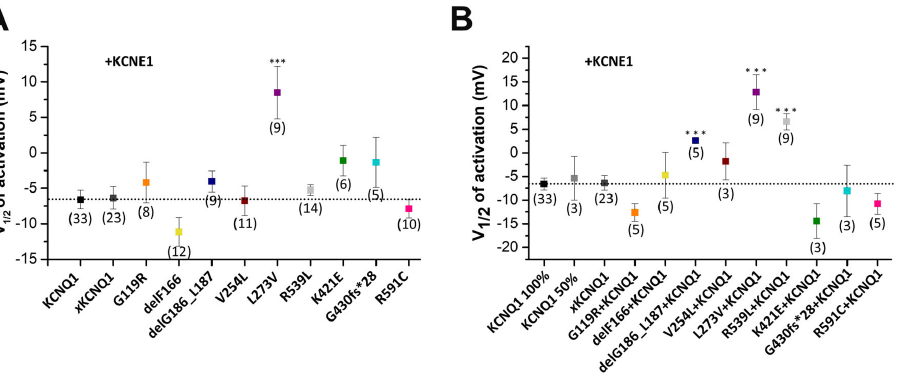
Figure 7. Voltage-dependence of activation of the KCNQ1 variants expressed in a homozygous or heterozygous complex with KCNE1. ( A ) Voltage-dependence of activation for homozygous KCNQ1 variants co-expressed with KCNE1 (81.2 ng KCNQ1 variants plus 1 ng KCNE1 or ( B ) in a heterozygous state with wild-type KCNQ1 and KCNE1 (40.6 ng KCNQ1 + 40.6 ng KCNQ1 variants + 1 ng KCNE1. Controls were: KCNQ1 100% = 81.2 ng KCNQ1 + 1 ng KCNE1, KCNQ1 50% = 40.6 ng KCNQ1 + 1 ng KCNE1, x KCNQ1 = 1 ng KCNE1. The tail current of each variant after the 7 s pulse was normalized to their maximum current. Recordings were performed with the protocol as described in Figure 6. The tail currents recorded after the 7 s pulse were normalized to the respective maximal tail current of each recording, to obtain the conductance/voltage (G/V) curves. Normalized tail currents were fitted to the Boltzmann function. The voltage of half-maximal activation (V 1/2 ) of the respective construct is illustrated, together with the numbers of oocytes analyzed. Values are expressed as means ± S.E.M. Error bars represent S.E.M. values. Significance was assessed using two tailed Student’s t -test. Asterisks indicate significance: ***, and p <